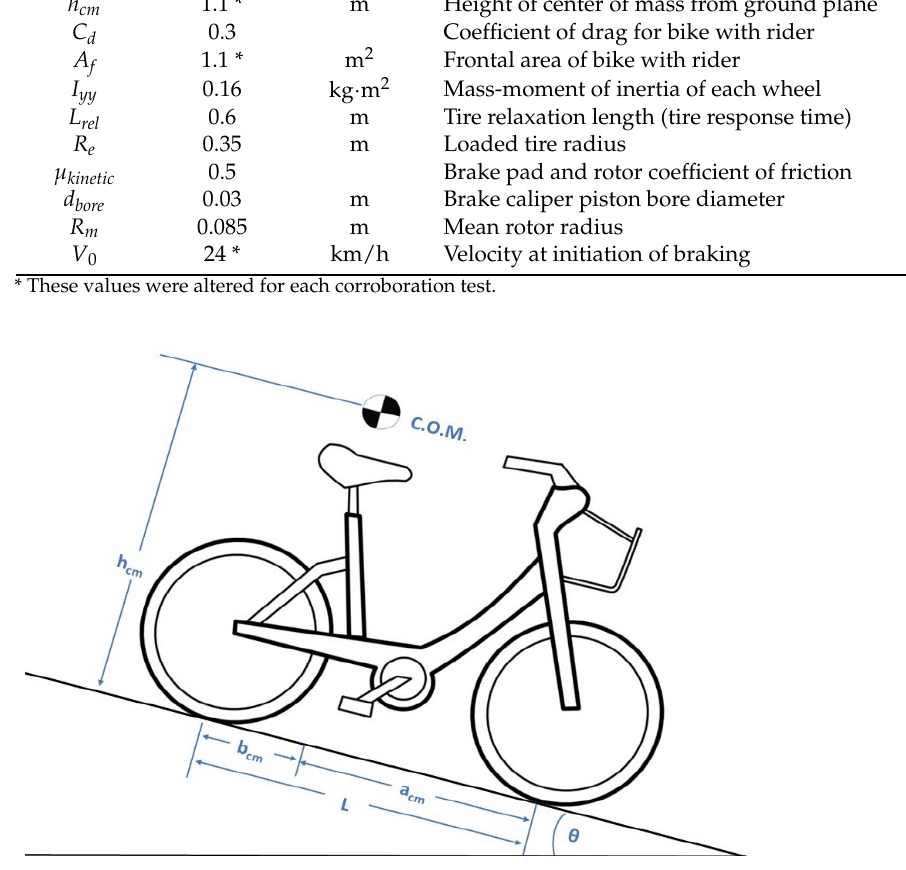
Figure 3. Locations of the dimensions described in Table 2 relative to the center of mass and ground plane.